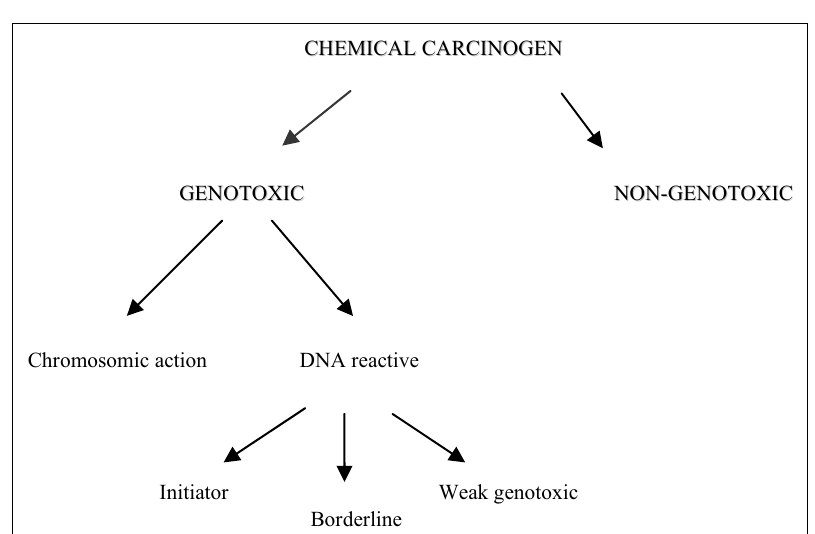
Fig. 4 – New proposal to classify chemical